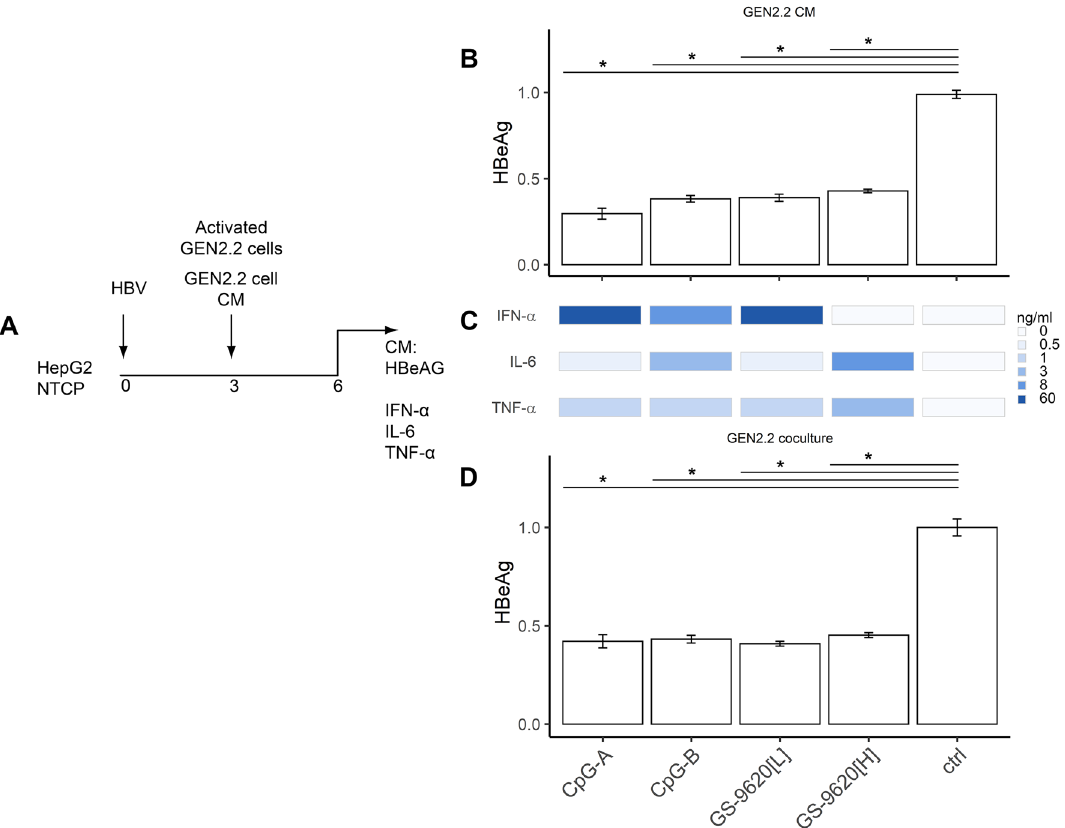
Figure 6. Antiviral activity of stimulated GEN2.2 pDCs on HBV-infected HepG2-NTCP cells. ( A ) Experimental flow chart. A total of 60,000 HepG2-NTCP cells were infected with 2000 VGE per cell of HBV and cultured for 3 days before CM from GEN2.2 cells stimulated with CpG-A (4 µg/ml), CpG-B (4 µg/ml), or GS-9620[L or H] (50 nM or 10 µM) was added ( B ). Levels of IFN-α, IL-6 and TNF-α ( D ) in CM were determined by ELISA 6 DPI. HBV-infected HepG2-NTCP cells were cocultured with 100,000 stimulated GEN2.2 cells ( C ). Production of HBeAg was normalized to production by HBV-infected HepG2-NTCP cells in the absence of pDCs. The data are shown as means ± SEM from three independent experiments. * p < 0.05, Mann–Whitney–Wilcoxon pairwise test, p value adjusted by BH